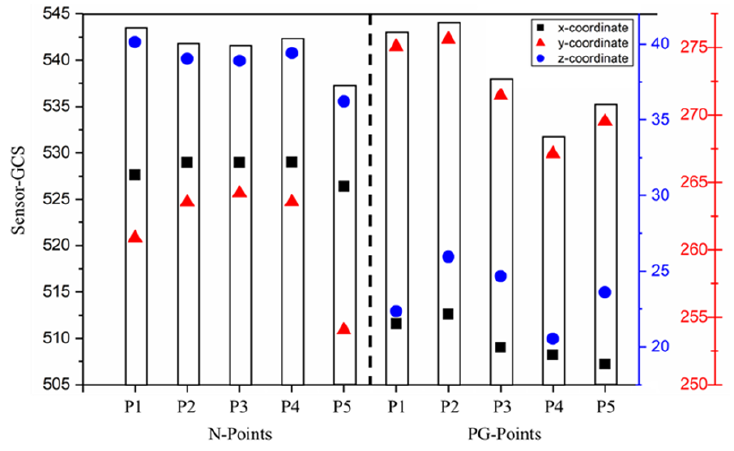
Figure 10. Coordinates of N and PG points in S–GCS.